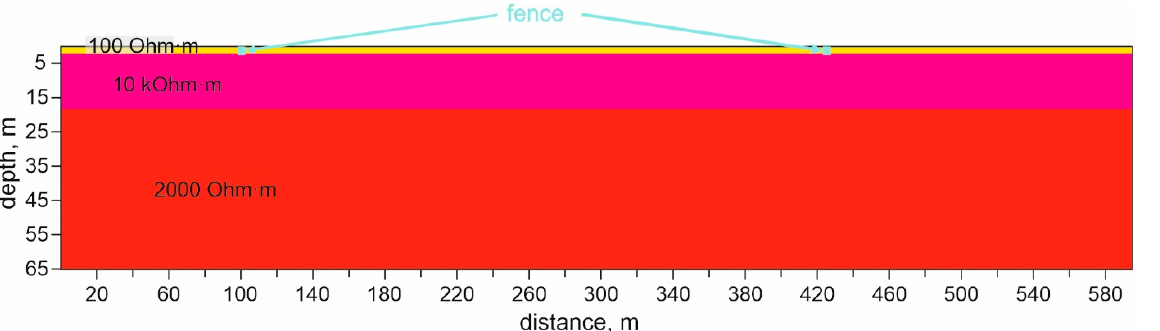
Figure 9. Layered-earth resistivity model with conductors (simulating a fence) embedded into the top layer. top layer.